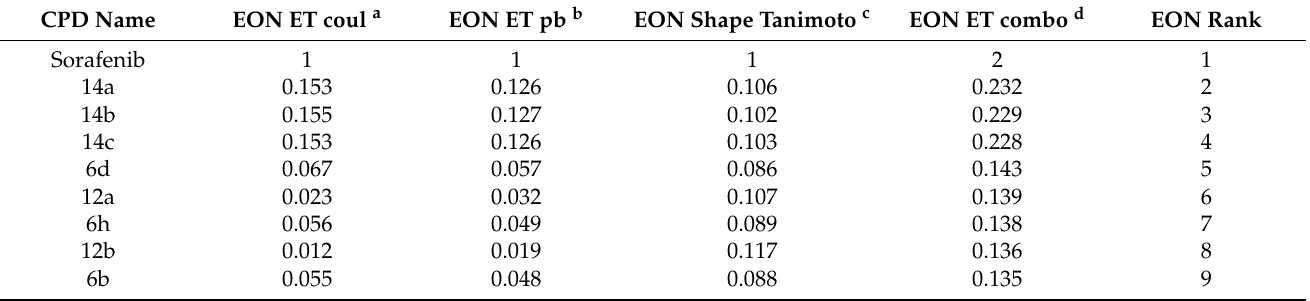
Table 2. EON shape and electrostatic potential similarity of target compounds with respect to the query drug